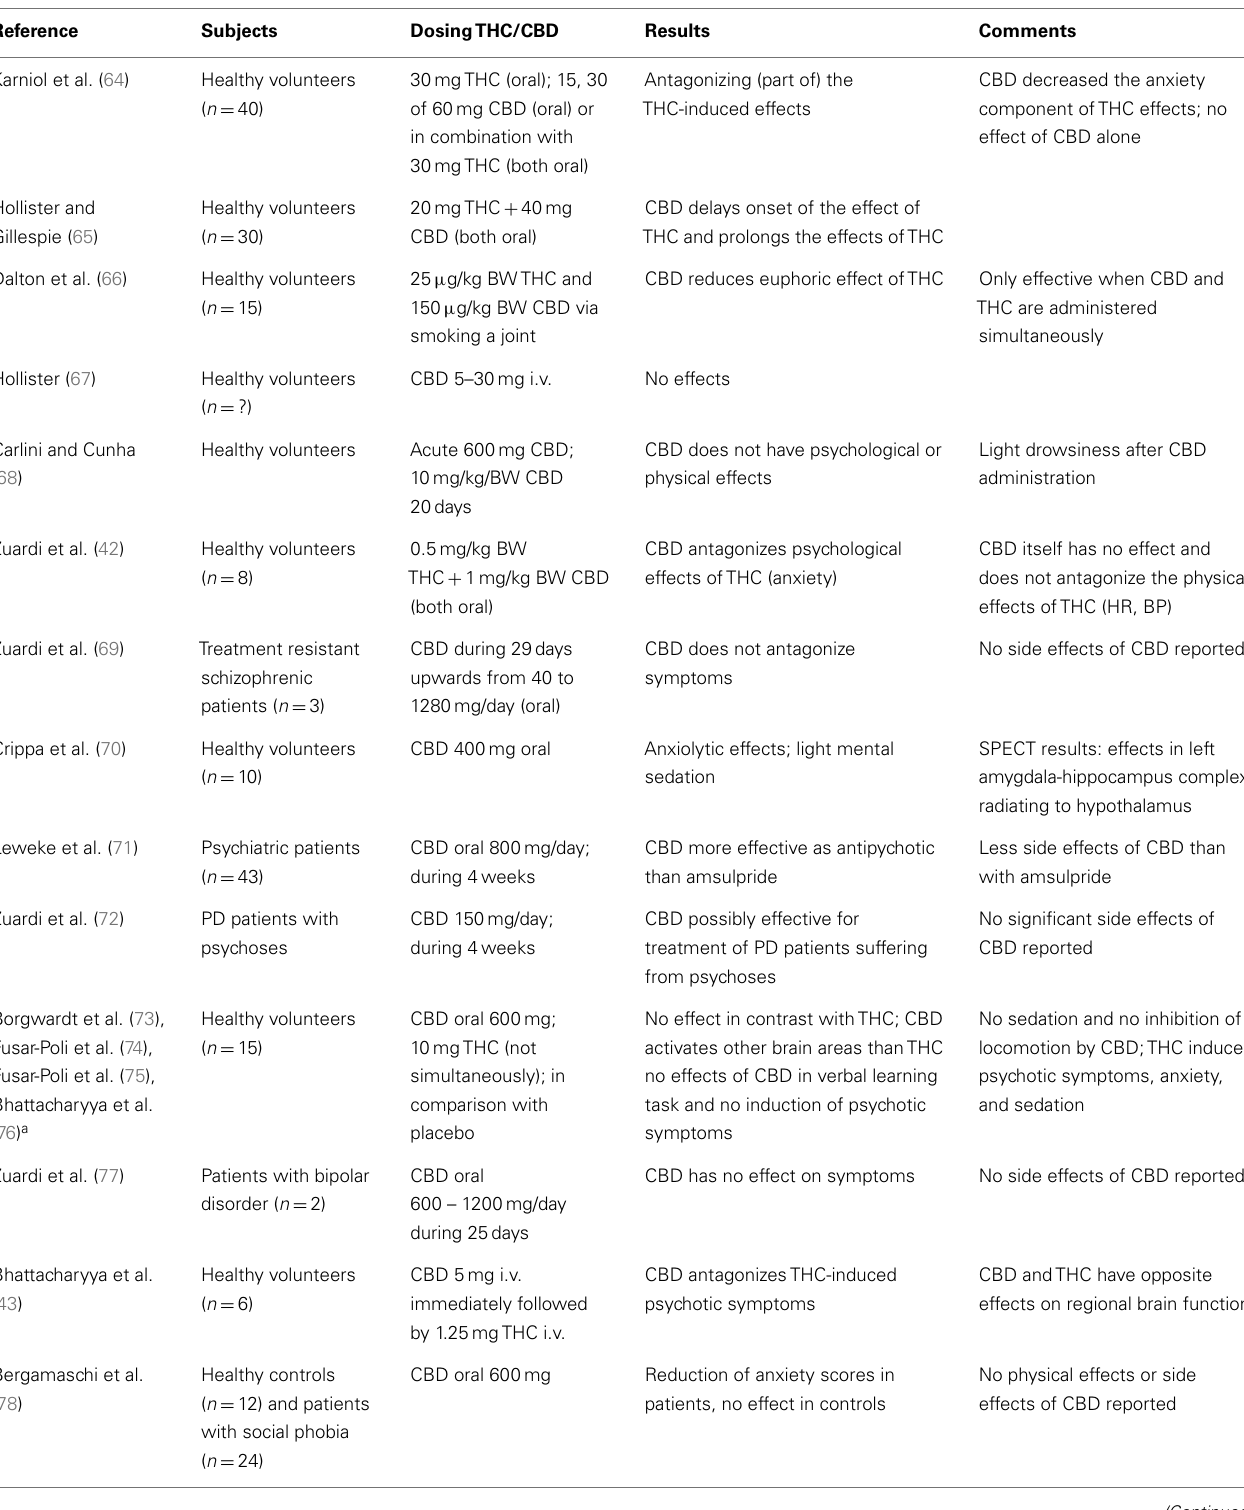
Table 2 | Overview of studies investigating the effect of cannabidiol or cannabidiol in combination withTHC on psychological functions in humans. Studies in which cannabis extracts have been used are not